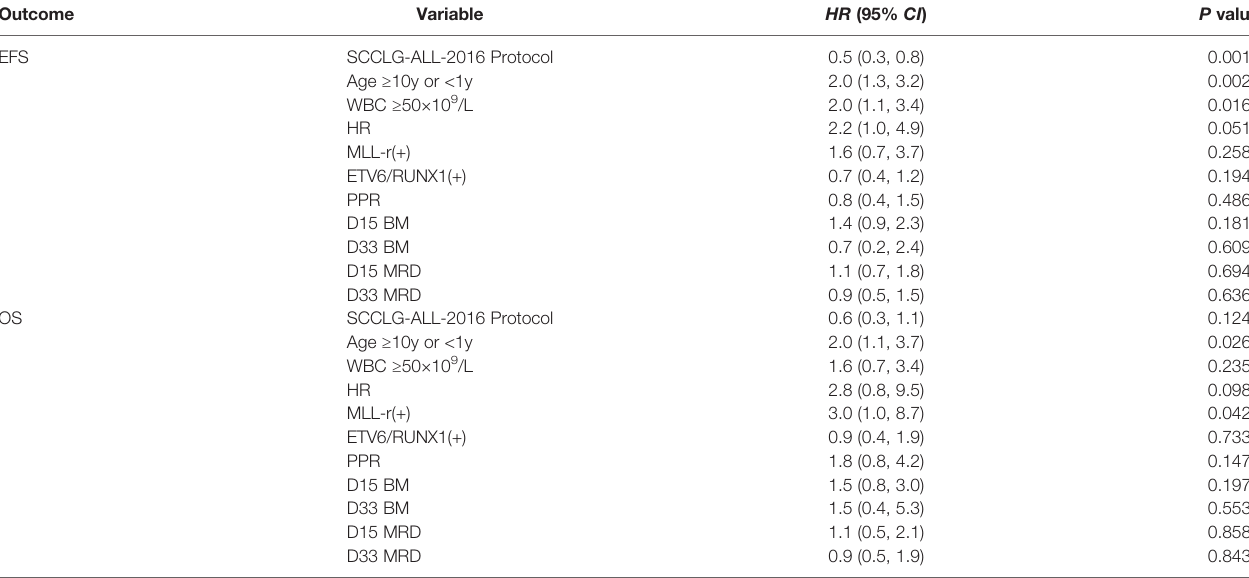
TABLE 3 | Multivariate analysis for EFS and OS among pediatric patients with B-ALL.